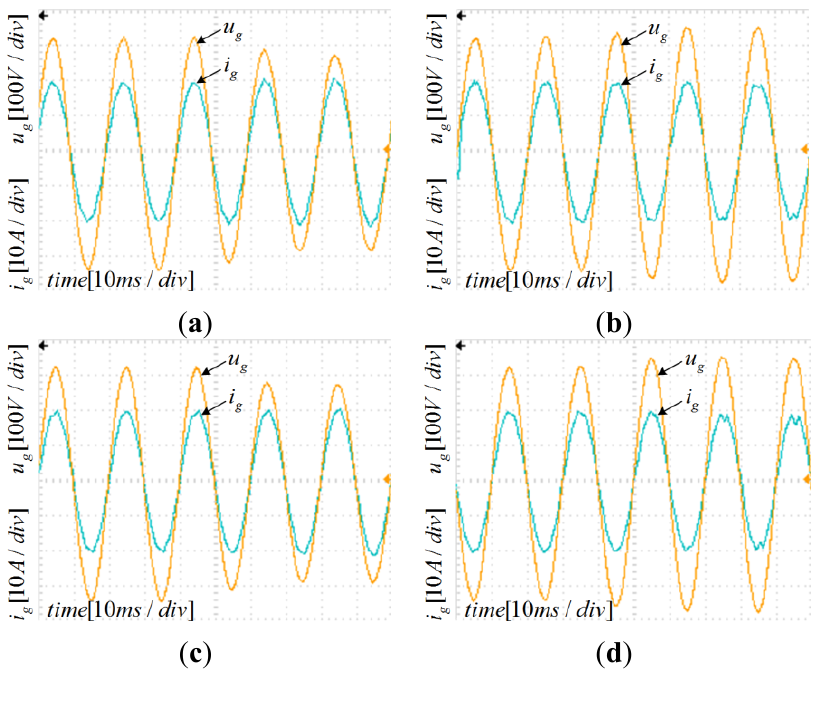
Figure 22. Grid voltage and injected current at full load with capacitor C variation: experimental results. ( a ) Capacitor C increased by 20%: grid voltage sag; ( b ) capacitor C increased by 20%: grid voltage swell; ( c ) capacitor C decreased by 20%: grid voltage sag; ( b ) capacitor C decreased by 20%: grid voltage